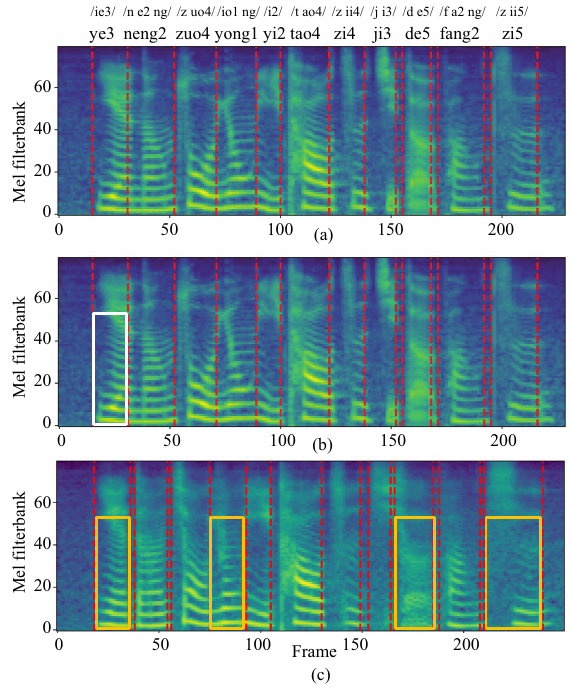
Figure 10. Mel-spectrogram visualizations of ( a ) ground-truth voice, ( b ) voice reconstructed by SSRNet, ( c ) voice reconstructed by the baseline.